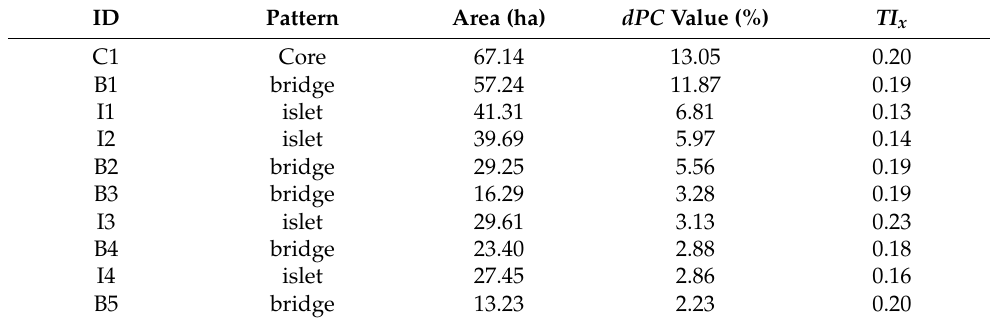
Table 5. Area, dPC values, threat levels, and spatial patterns of important cores, bridges and